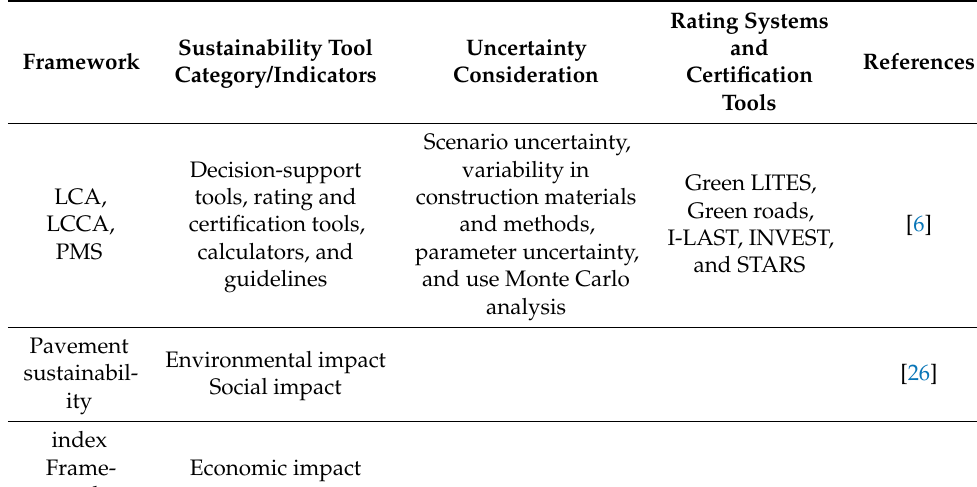
Table 5. Sustainability framework, rating system, indicators, and